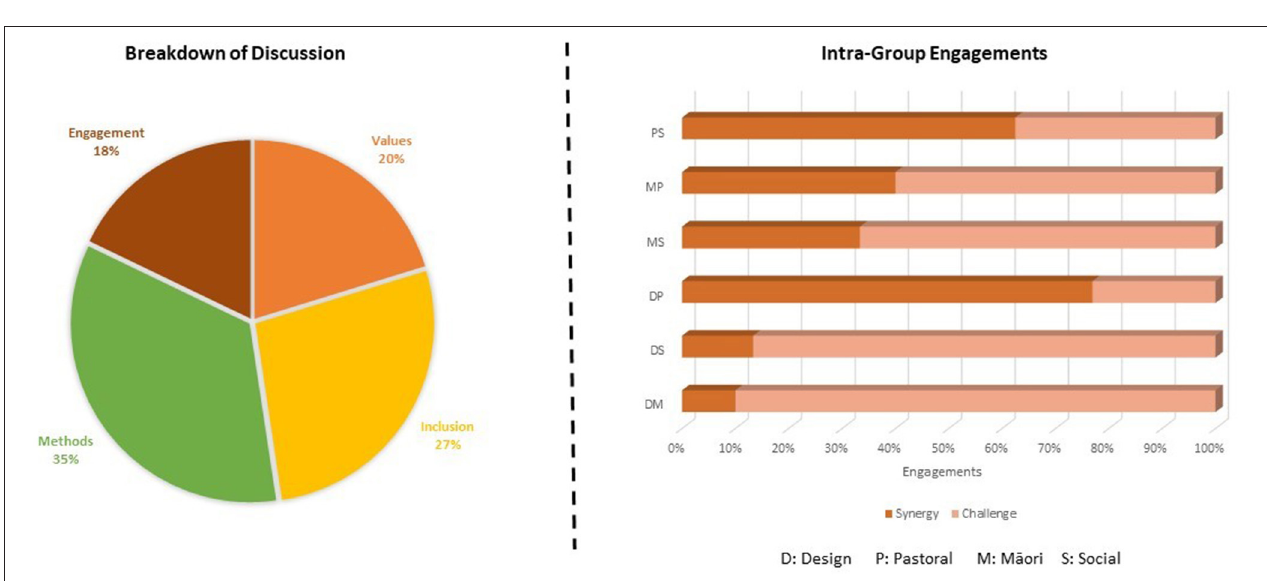
FIGURE 2 | The Salient features driving our co-production process at the COE.